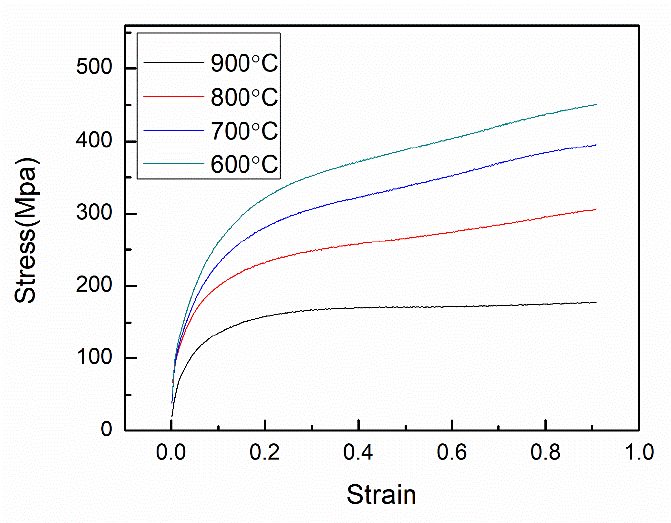
Figure 9. The true stress–strain curves for the low-carbon ferritic stainless steel samples deformed at the different temperatures.